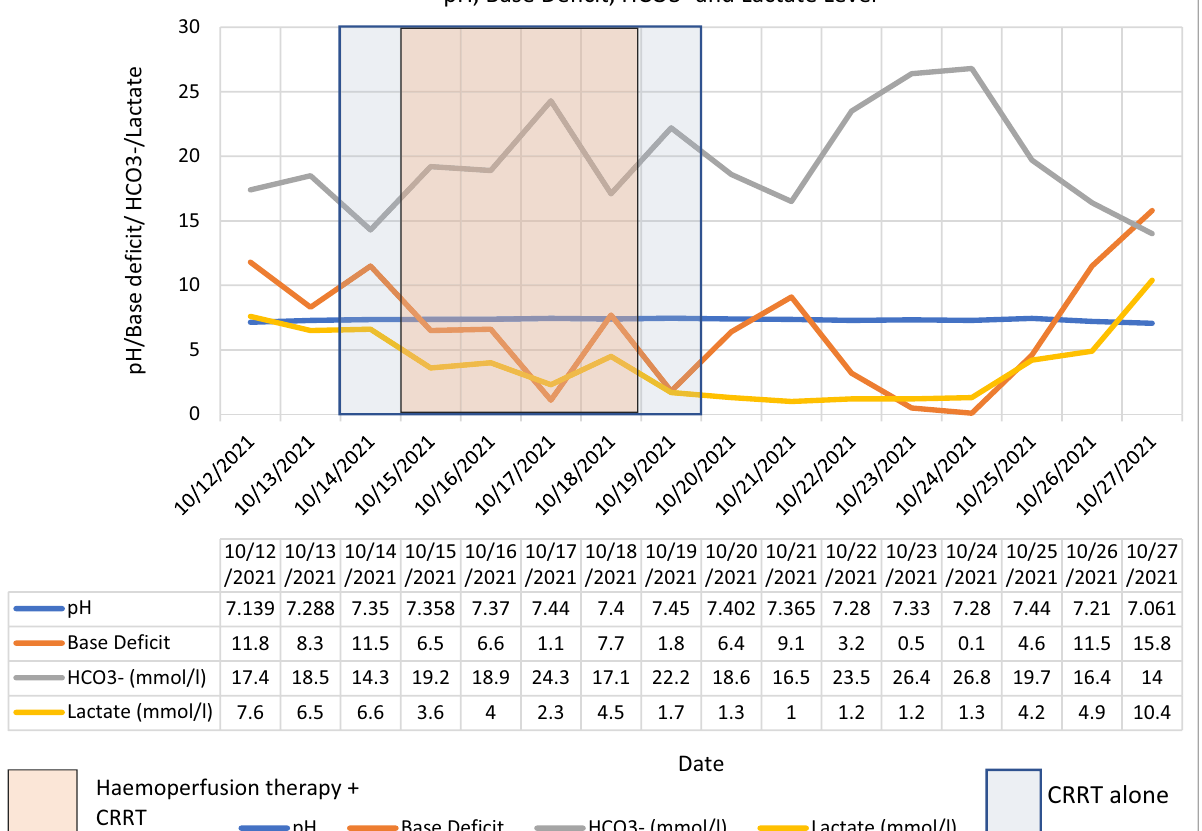
HCO3- (mmol/l) 17.4 18.5 14.3 19.2 18.9 24.3 17.1 22.2 18.6 16.5 23.5 26.4 26.8 19.7 16.4 Lactate (mmol/l) 7.6